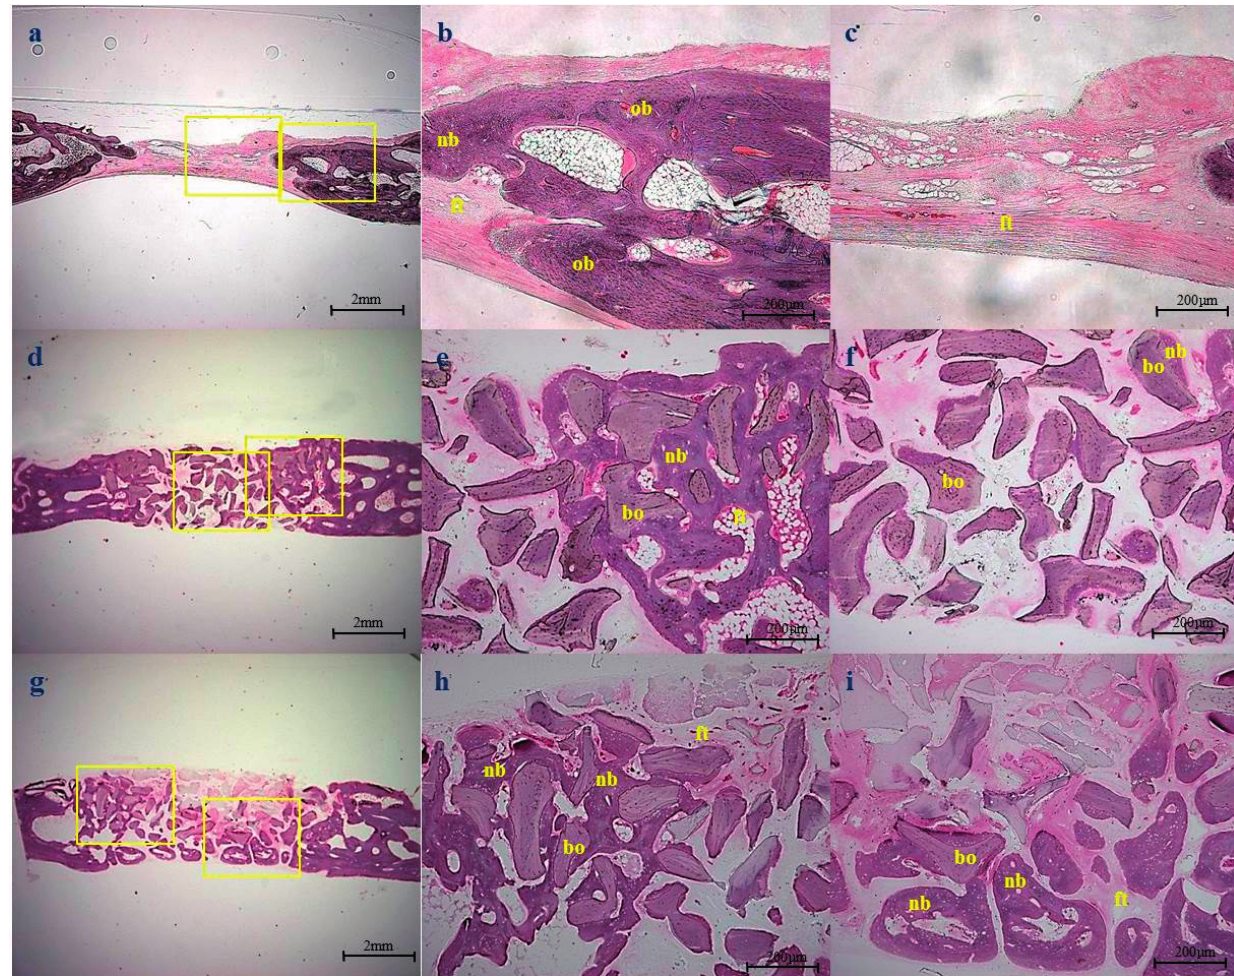
Figure 8. Histologic sections at eight weeks after surgery: ( a – c ) non-implanted control group, showing new bone (nb) formation from the cut edge; ( d – f ) Bio-Oss ® group. New bone formation was observed between particles, but no new bone was observed in the middle portions of defects; ( g – i ) BMP-2/Bio-Oss ® group. New bone was of greater quality than in the Bio-Oss ® group. Original magnifications were ×12.5 for ( a , d , g ) and ×40 for the others. (nb: new bone, ft: fibrovascular tissue, bo: Bio-Oss ® particle, ob: old